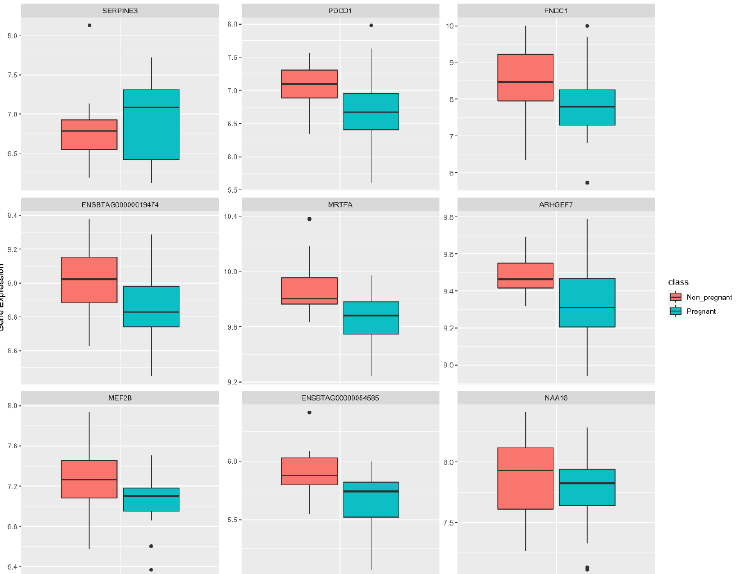
Figure 2. Normalized gene expression of candidate biomarkers discriminating between pregnant (P) and non-pregnant (NP) cows. Boxplot limits are associated with the first (lower) and third (upper) quartiles. Horizontal lines within the boxplots represent the median of normalized expression data for each cohort (P and NP). Black dots outside the vertical range of whiskers represent outliers.